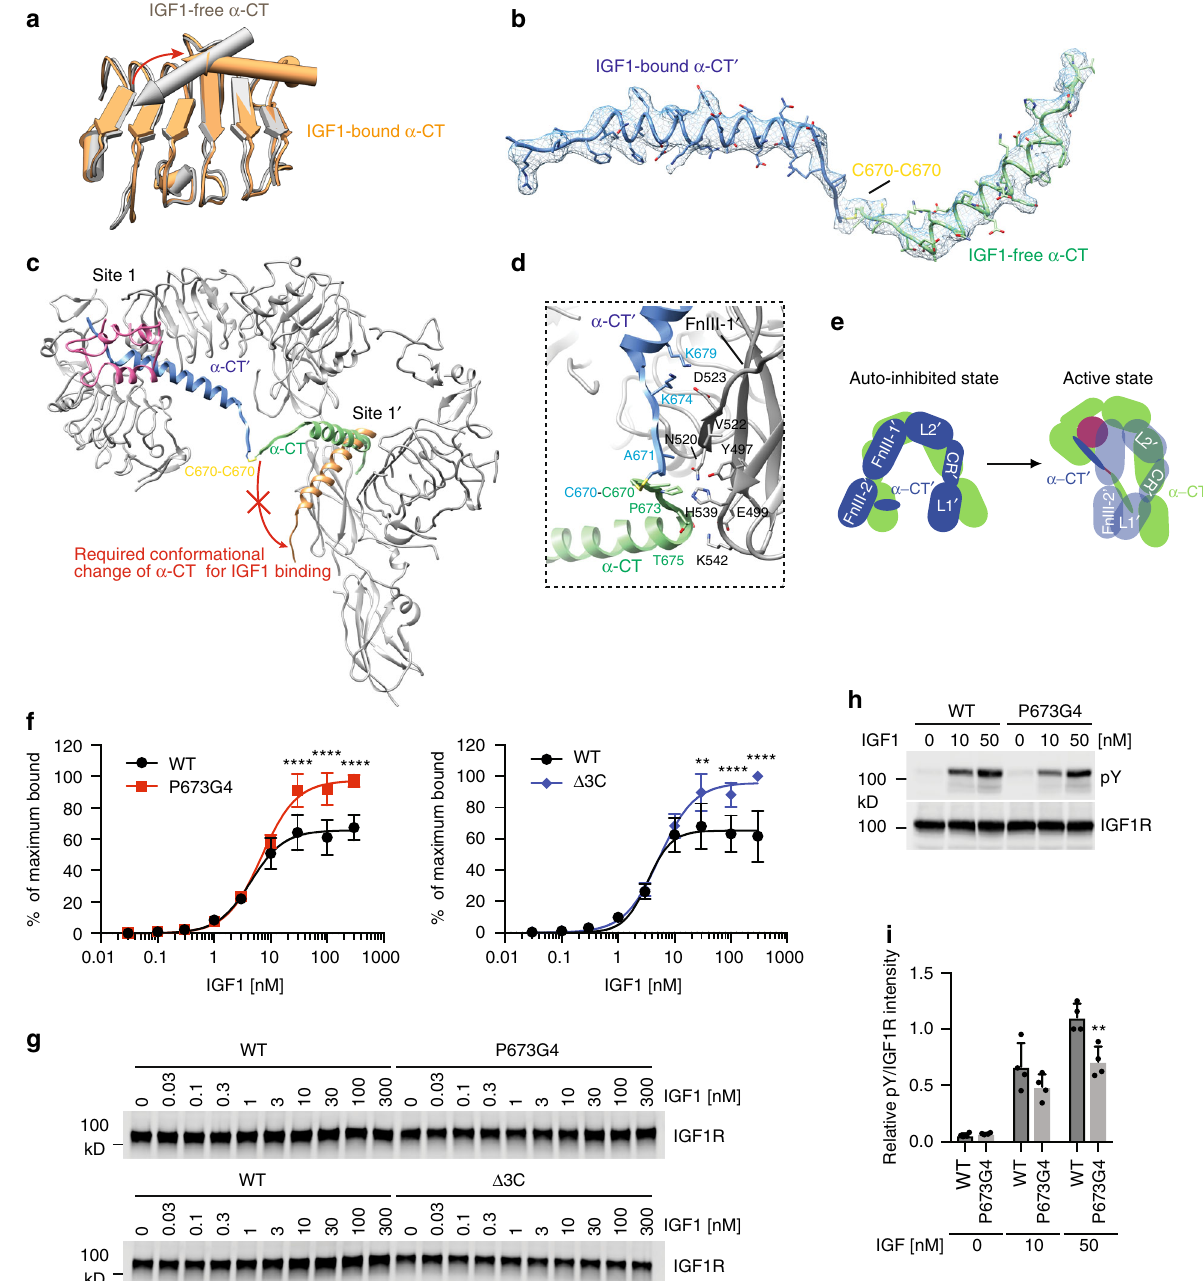
Fig. 4 The source of negative cooperativity in the binding of IGF1 to IGF1R. a Superposition between IGF1 bound L1/ α -CT ′ (orange) and apo L1/ α -CT ′ (grey) by aligning the L1 domain, revealing the conformational change of α -CT ′ upon IGF1 binding. b Cryo-EM density of dimerized α -CT motifs. c Overall view of dimerized α -CT motifs in the context of IGF1R active dimer. Part of the model is removed for clarity. IGF1 bound α -CT ′ (orange) is superposed with the unliganded α -CT (green) in the IGF1R active dimer by aligning the L1 domain, revealing the required conformational change of α -CT for IGF1 binding (indicated by a red arrow). d Close-up view of the α -CTs/FnIII-1 ′ interaction in the IGF1R active dimer. e Cartoon model illustrating the structural difference of two α -CT motifs between the apo and active states of IGF1R. f Binding of IGF1 labeled with Alexa Fluor 488 to 293FT cells expressing IGF1R WT or IGF1R mutants (Mean ± SD). Each experiment was repeated three times. Signi fi cance calculated using two-tailed students t-test; between WT and mutants, ** p < 0.01 and **** p < 0.0001. g Representative western blot images of the amount of IGF1R in f . h IGF1-induced IGF1R autophosphorylation in 293FT cells expressing WT IGF1R or P673G4. i Quanti fi cation of the western blot data shown in h (Mean ± SD). Each experiment was repeated four times. Signi fi cance calculated using two-tailed students t -test; between WT and mutants; ** p < 0.01. Source data are provided as a Source Data fi